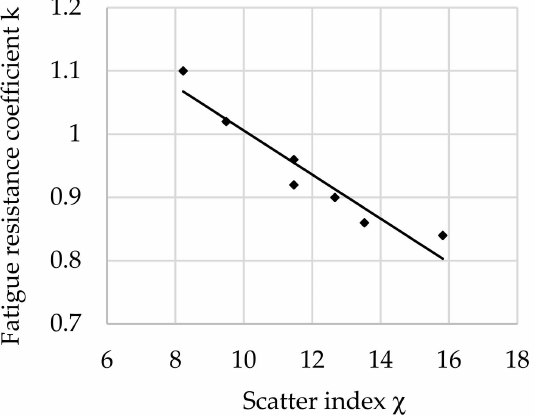
Figure 4. The relationship between the fatigue resistance coefficient and scatter index of structural steel hardened and tempered at 200 ◦